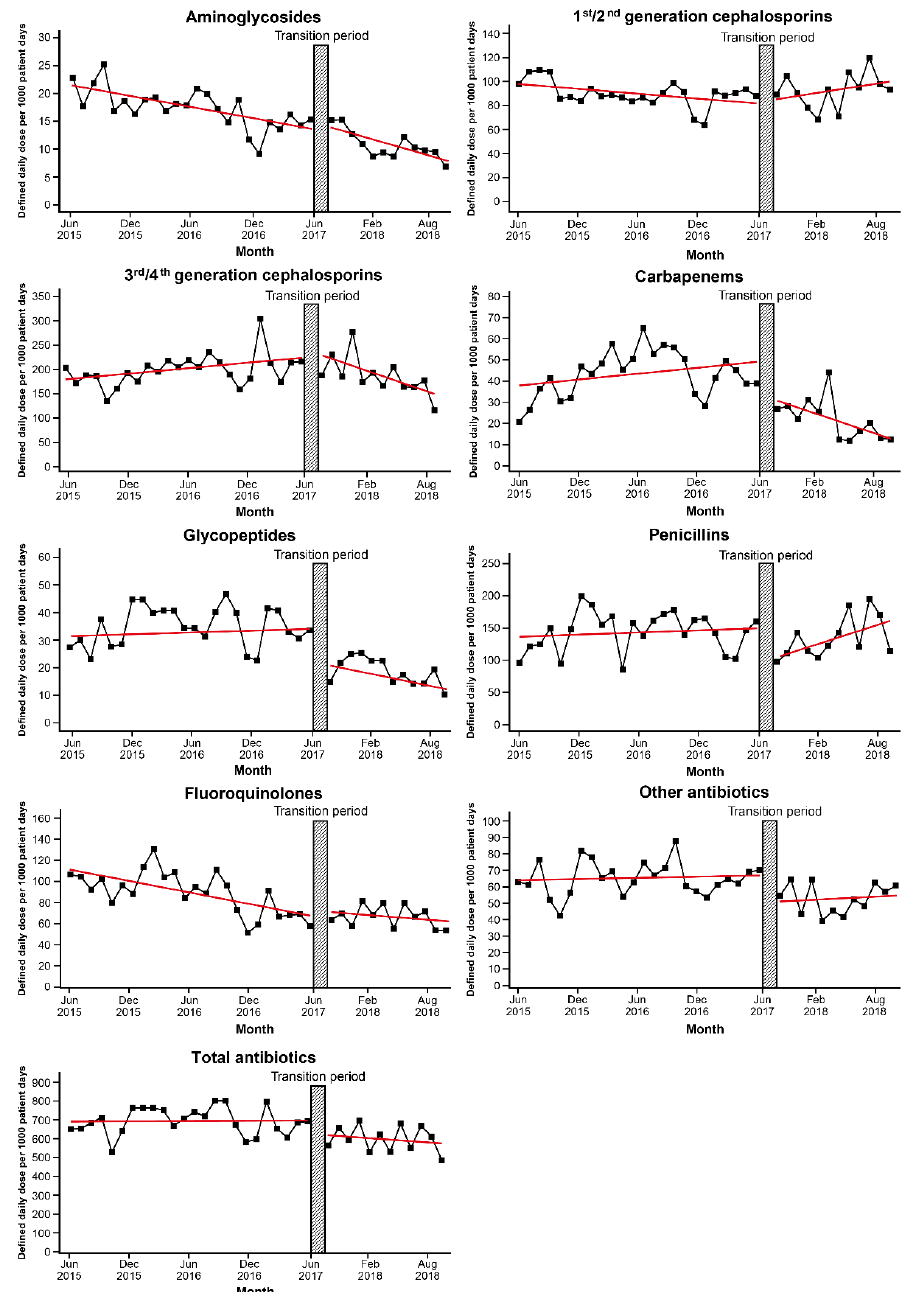
Figure 1. Trends in antibiotic use before and after implementation of the antimicrobial stewardship program led by an infectious disease specialist. Transition period is a three-month lag allowing for the intervention process to